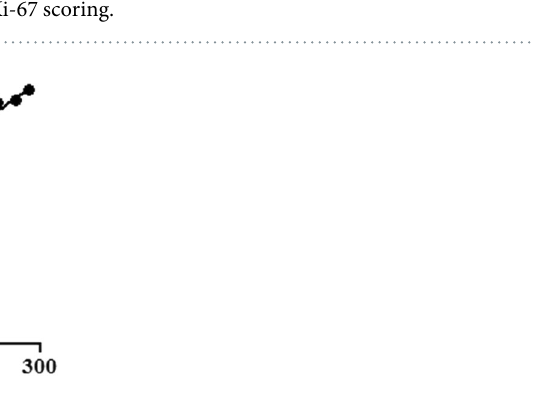
Table 5. Quantitative performance measures for Ki-67 scoring.